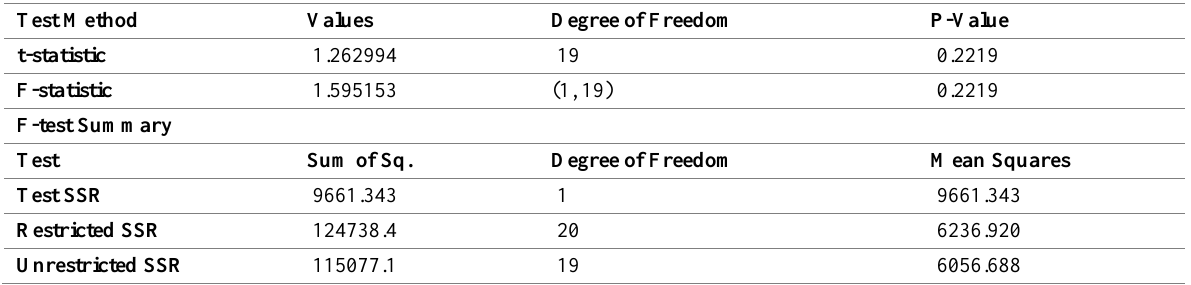
Table 8: Ramsey RESET Test for Functional